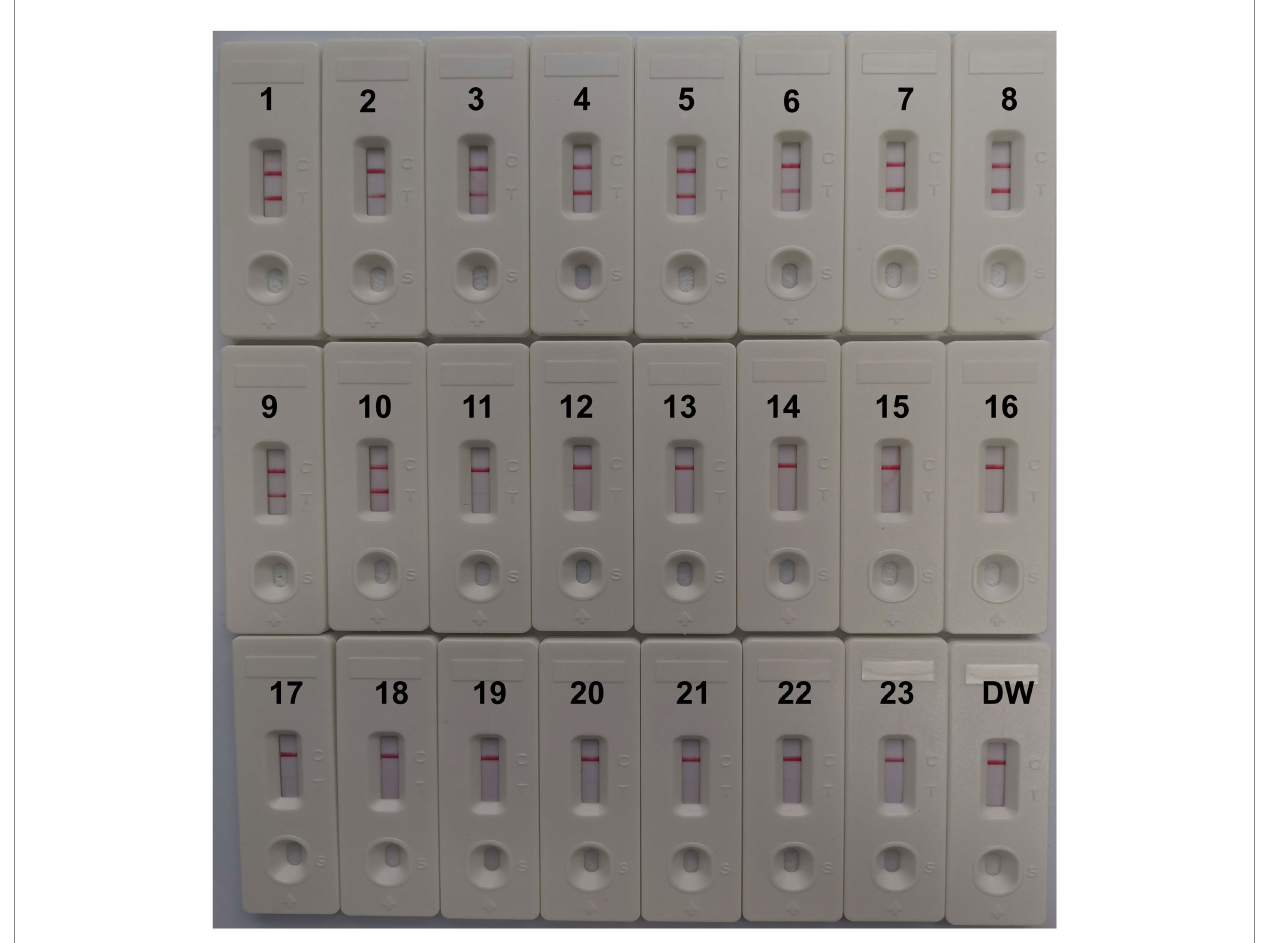
FIGURE 7 Specificity of LFB assays detecting CVA16-MCDA-LFB products. The CVA16-MCDA-LFB assay was evaluated with different genomic DNA as templates. Both the control line and the test line were visible in LFB for all CVA16, and only the control line was appeared in non-CVA16. 1–10, CVA16 isolated strains; 11, EVA71 isolated strains; 12, CVA2 isolated strains; 13, CVA4 isolated strains; 14, CVA6 isolated strains; 15, CVA10 isolated strains; 16, CVA24 isolated strains; 17, CVB3 isolated strains; 18, ECHO30 isolated strains; 19, EVC96 isolated strains; 20, Human rhinovirus clinical samples; 21, Norovirus